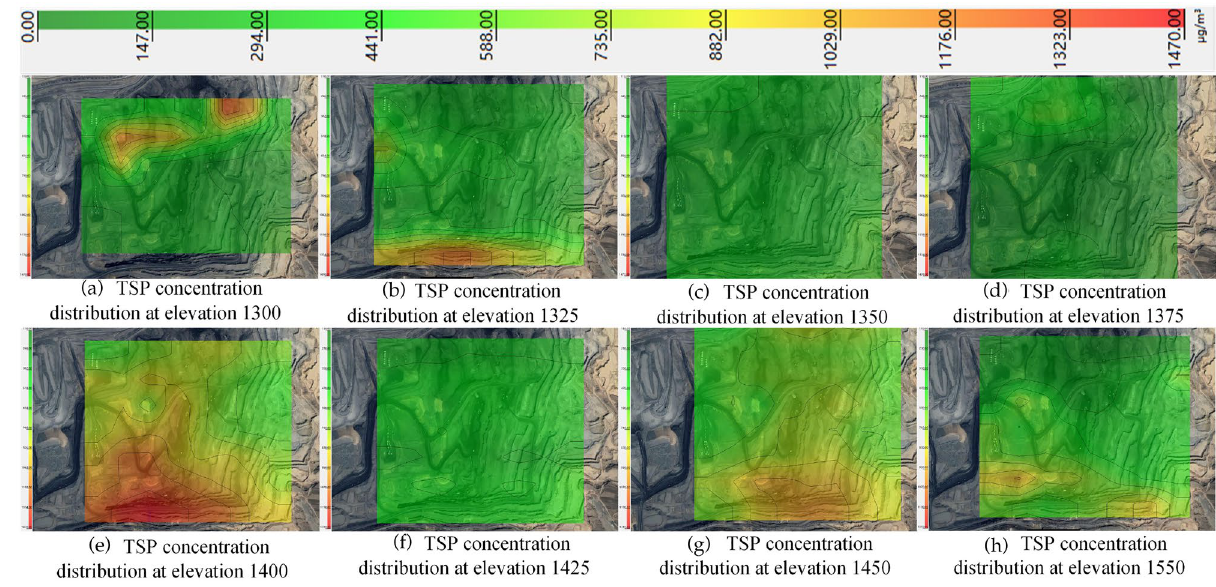
Figure 12. TSP distribution from 1300 to 1550 elevation in